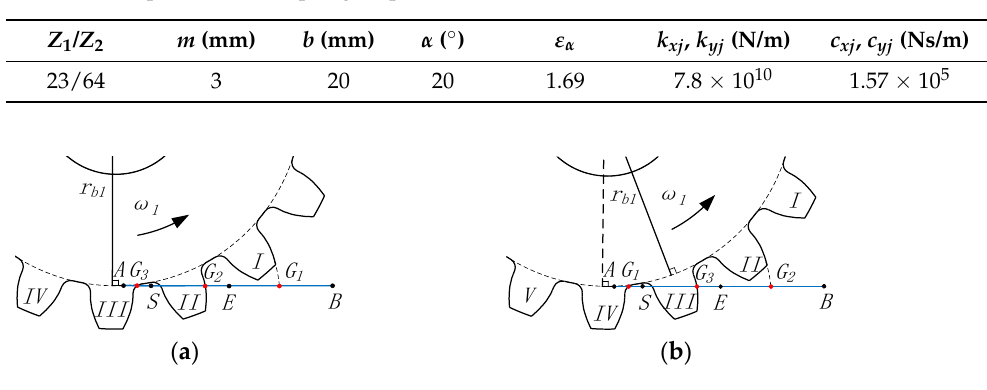
Figure 3. Gear mesh analysis, t 1 < t 2 : ( a ) t 1 ( b ) t 2